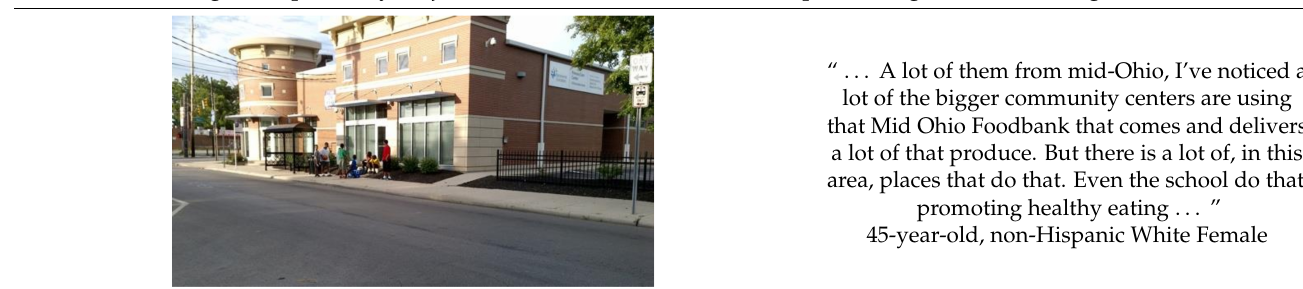
Table 2. Cont. Representative Quote(s) from Project SWEAT HEALth MAPPS Participant In-depth Interviews and Focus Groups and Image(s) Captured by Project SWEAT HEALth MAPPS Participants using the Garmin Oregon 650